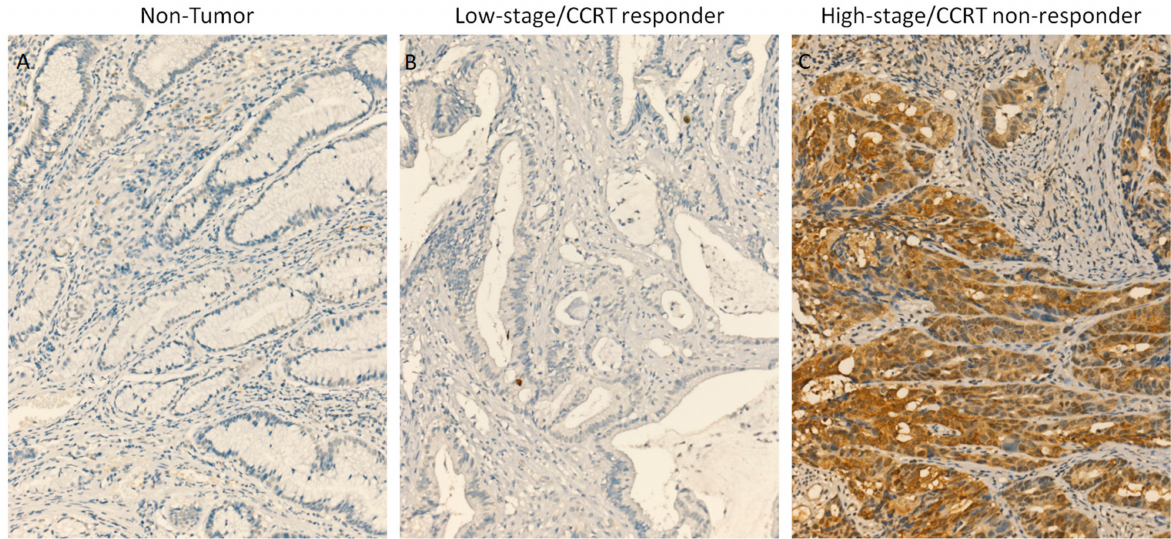
Figure 2. Immunohistochemical staining of melanophilin (MLPH) expression in: ( A ) normal mucosa: no MLPH expression; ( B ) rectal carcinoma responsive to chemoradiation: low MLPH expression; and ( C ) rectal carcinoma unresponsive to chemoradiation: high MLPH